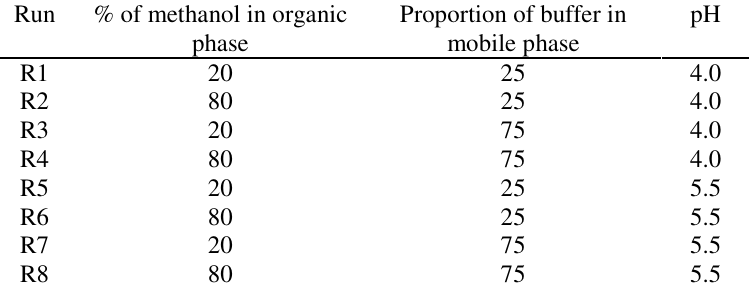
Table 2 . Chromatographic conditions employed as per 2 3 factorial